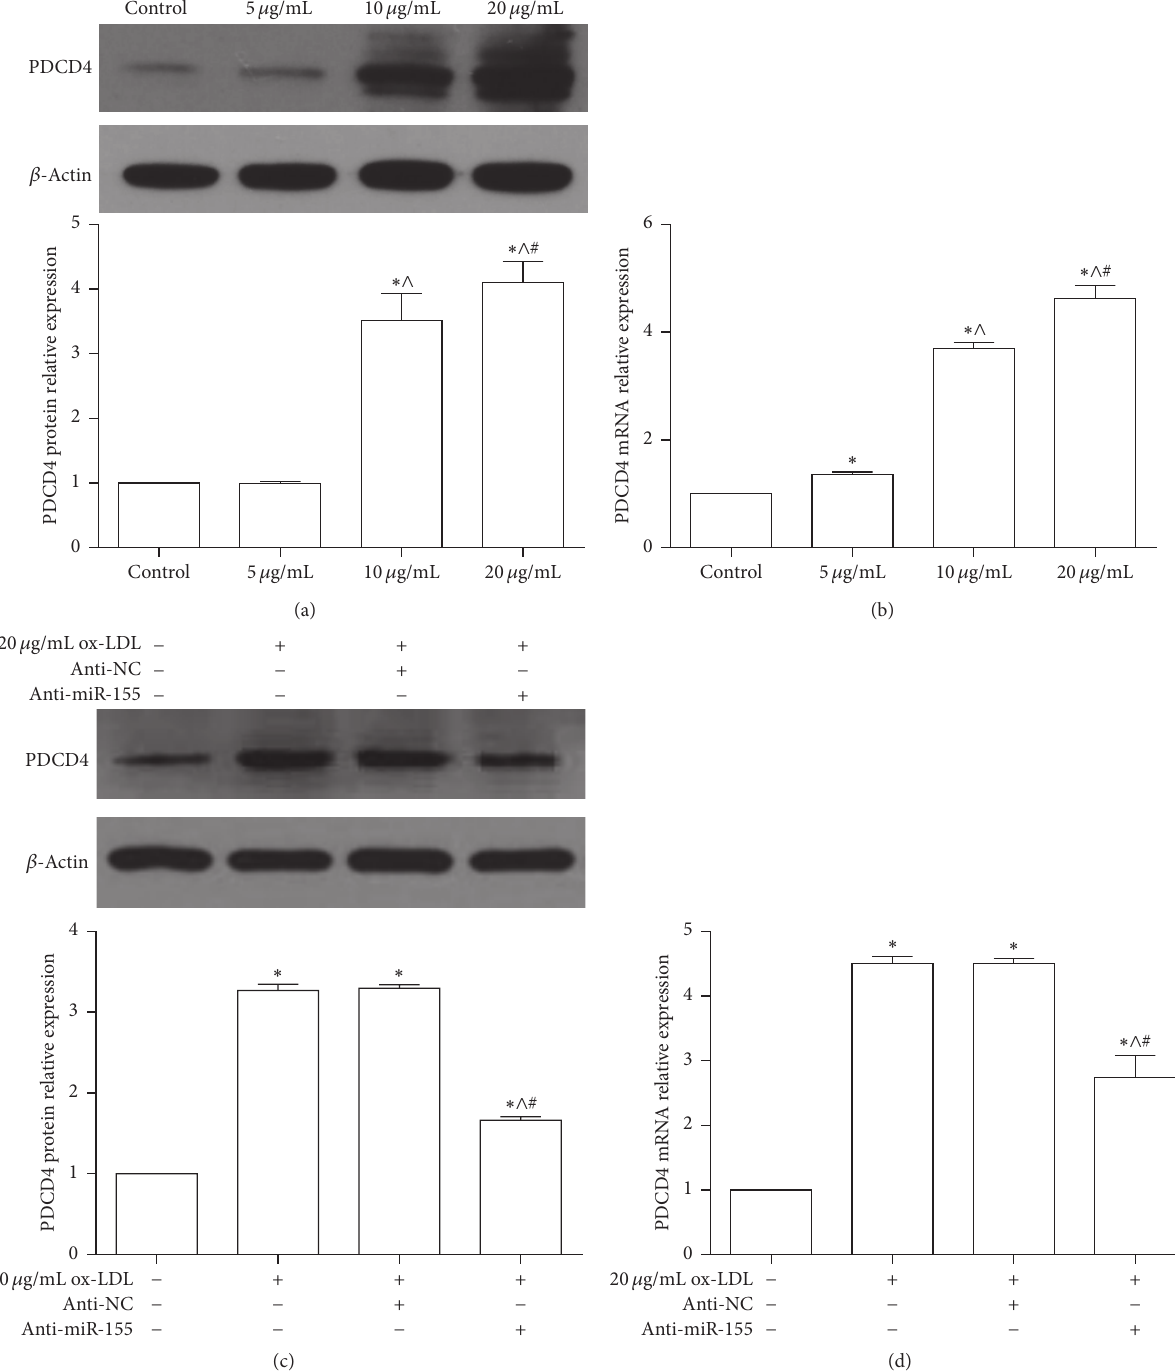
Figure 3: The relative expression of PDCD4 in macrophages RAW264.7 cells. (a and b) Western blot and qPCR analyzed the PDCD4 protein and mRNA expression after indicated ox-LDL treated macrophages RAW264.7 cells for 24 h. Representative bands show the protein expression of PDCD4 (the upper panel), 𝛽 -actin (the middle panel), and the histograms showing quantification of PDCD4 bands normalization relative to 𝛽 -actin expression in (a): ∗ 𝑝 < 0.05 versus control, ∧ 𝑝 < 0.05 versus 5 𝜇 g/mL group, and # 𝑝 < 0.05 versus 10 𝜇 g/mL group. (c and d) Western blot and qPCR analyzed the PDCD4 protein and mRNA expression while RAW264.7 cells were treated by 20 𝜇 g/mL ox-LDL plus anti-miR-155 or anti-NC. 100 pM anti-miR-155 or anti-NC had been transfected into RAW264.7 cells for 24 h, and then they were treated by 20 𝜇 g/mL ox-LDL for 24 h. Representative bands show the protein expression of PDCD4 (the upper panel), 𝛽 -actin (the middle panel), and the histograms showing quantification of PDCD4 bands normalized relative to 𝛽 -actin expression in (c): ∗ 𝑝 < 0.05 versus control, ∧ 𝑝 < 0.05 versus 20 𝜇 g/mL ox-LDL group, and # 𝑝 < 0.05 versus 20 𝜇 g/mL ox-LDL plus anti-NC